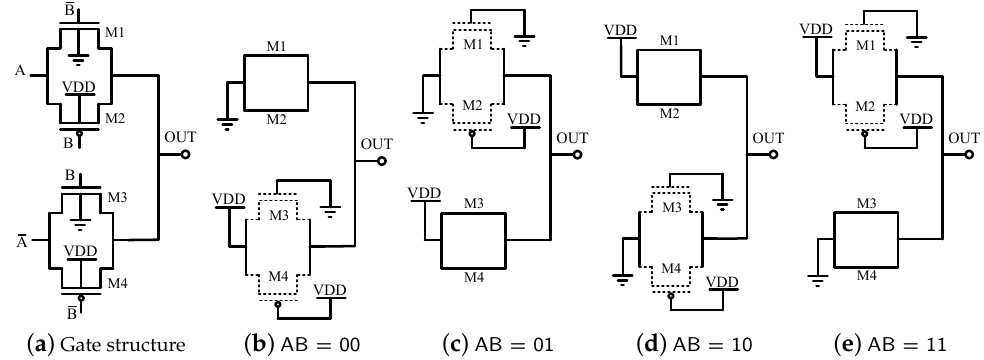
Figure 6. BSPL XOR gate, and the status of the transistors for different input values (inverters to generate A and B are not